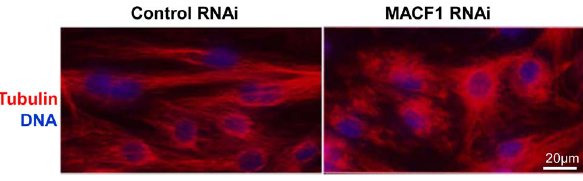
Figure 8. MACF1 depletion alters microtubule organization in neonatal rat cardiomyocytes. Neonatal rat ventricular cardiomyo- cytes(NRVMs) transfected with MACF1 RNAi or non-targeting control RNAi were immunostained for tubulin (red). Hoescht stain (blue) was used to identify nuclei.